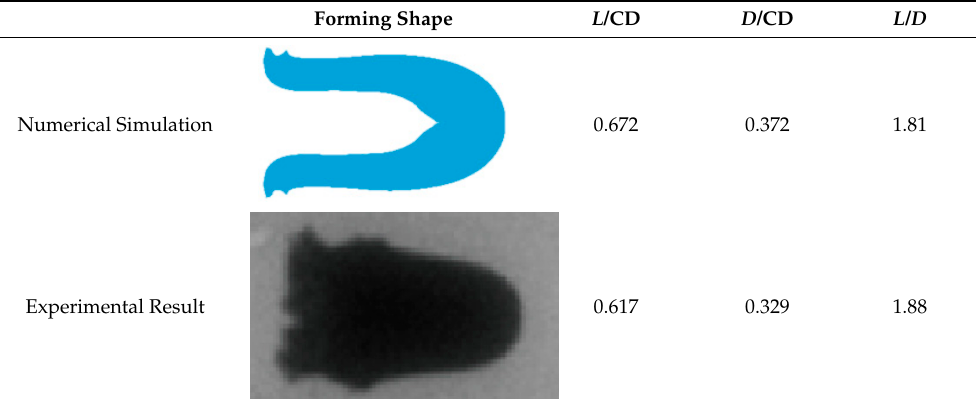
Table 8 makes a comparison of numerical simulation and experiment results. L and D are the length and diameter of EFP, and L/D is the length to diameter ration of EFP. By